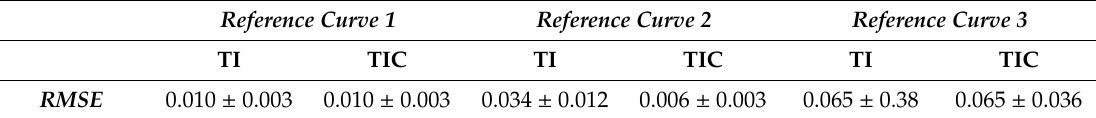
Table 9. Root mean square error ( RMSE ), in kg, for the comparison between the end bodyweight from the curves obtain following the suggestions from the MPC systems using the time-invariant parameters transfer function model, without (TI) and with constraints (TIC) and the three theoretical bodyweight reference curves generated.